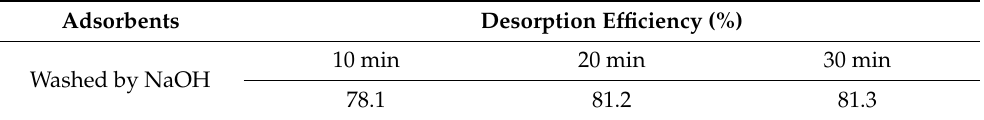
Table 6. Desorption efficiency of Pb(II) ions from NaOH adsorbent with 0.1 M HCl.